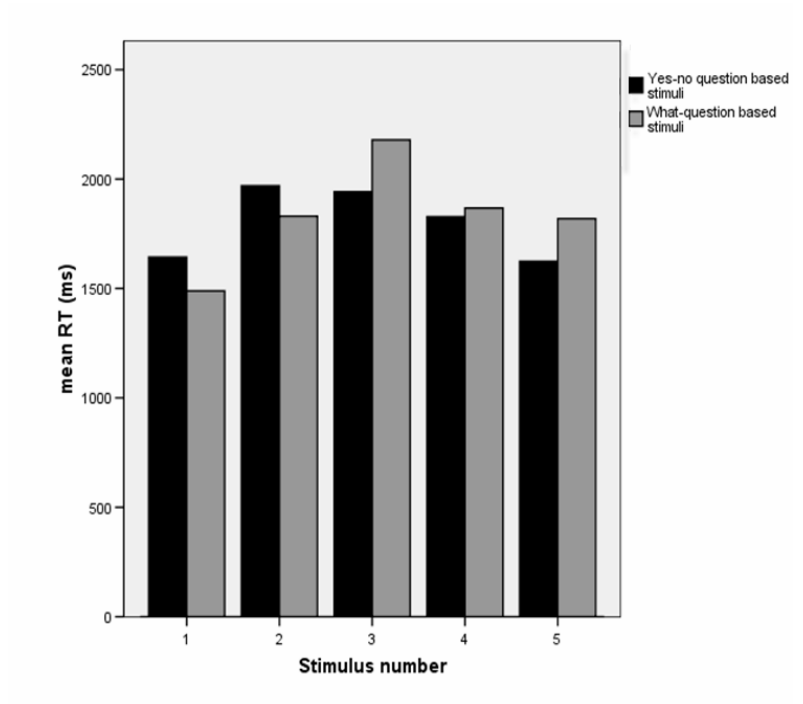
Figure 5. Mean RTs of the peak height continua created from yes-no question and what-question base